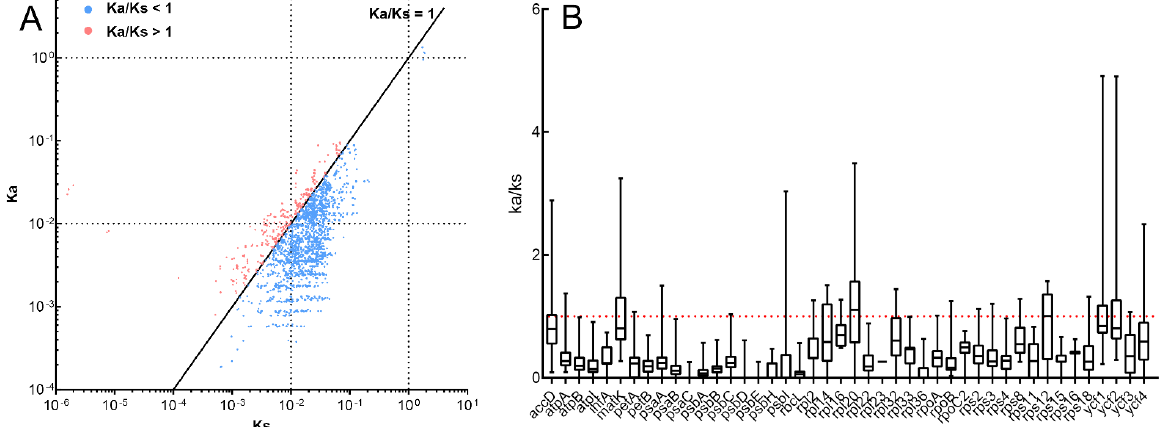
Figure 7. Selective pressure of shared protein coding genes in Paphiopedilum . ( A ) The x-axis represents the Ks (synonymous substitutions) value, while the y-axis represents the Ka (non-synonymous substitutions) value. Red dots represent gene pairs under positive selection ( Ka/Ks > 1), and blue dots represent gene pairs under purifying selection ( Ka/Ks < 1). ( B ) Overall distribution pattern of the Ka/Ks value of each gene in Paphiopedilum